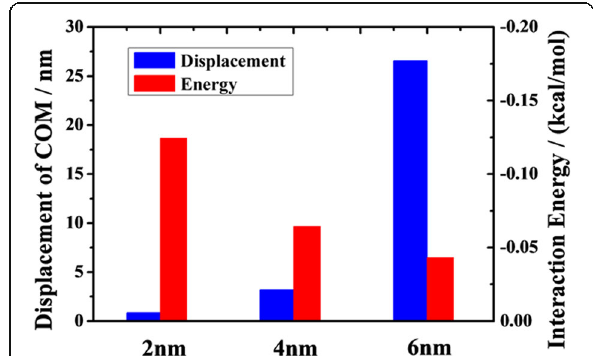
Fig. 3 The COM displacements of oil at 2 ns and average interaction energies between the oil and the channel versus channel width